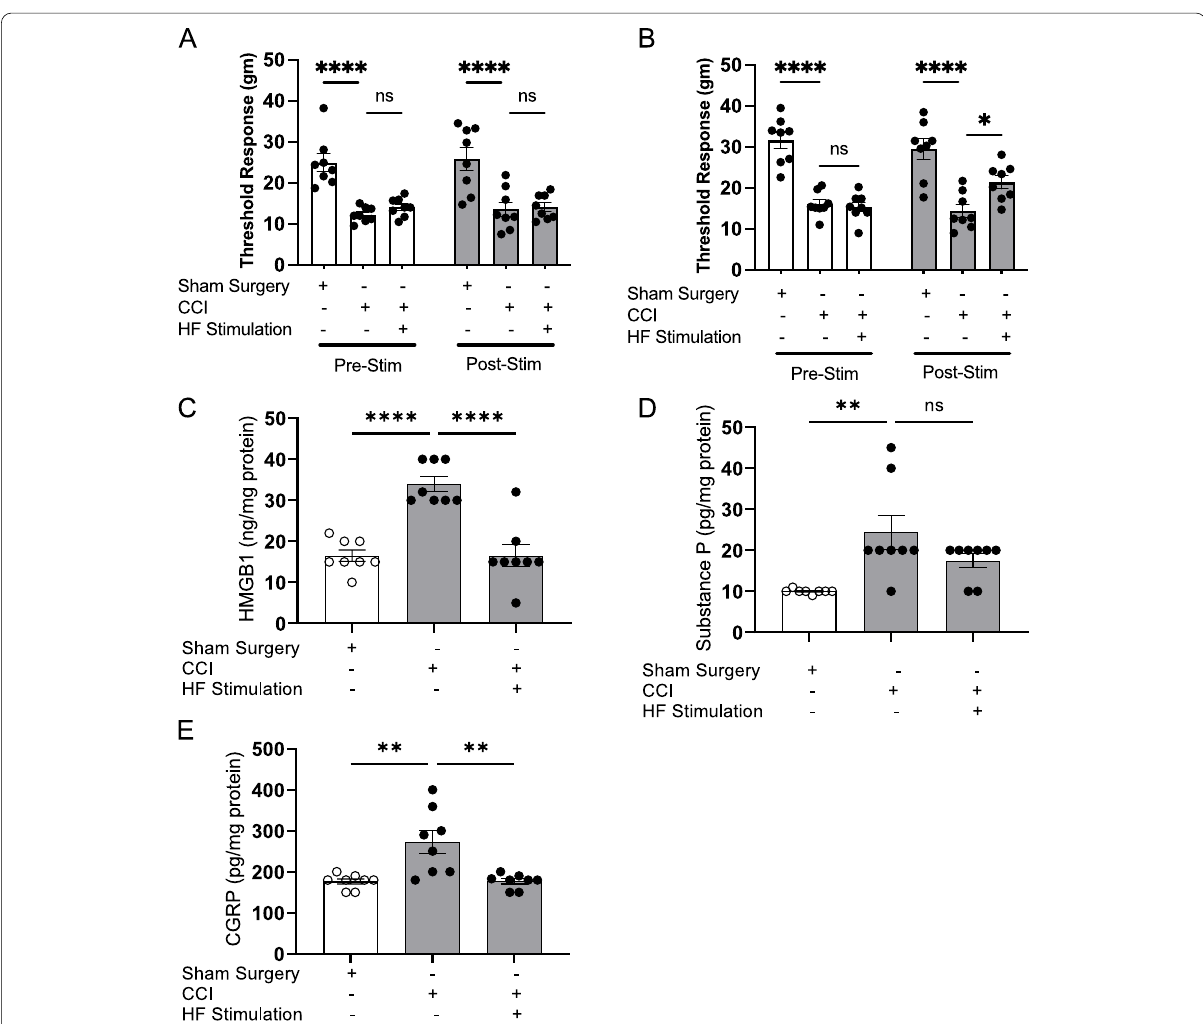
to CCI of the right sciatic nerve or sham surgery. Two weeks after sciatic nerve ligation surgery or sham surgery, animals were anesthetized, and transcutaneous high frequency electrical stimulation was applied for 5 min perpendicularly and parallel to the injury site, for a total of 10 min once a day A for 1 day or B for 3 consecutive days. Mechanical hypersensitivity (von Frey) was assessed at 24 h after the last stimulation. Data are represented as individual rat data points with mean SEM. Two‑way ANOVA was used followed by Tukey’s multiple comparisons test between ± groups. N 8‑12 per group. * P < 0.05, **** P < 0.0001. ns: not significant. C ‑ E CCI animals stimulated once a day for 3 consecutive days were = euthanized post‑mechanical hypersensitivity assessment and levels of C HMGB1, D substance P, and E CGRP were measured in the interstitial fluid of the inflamed paws. Data are represented as individual rat data points with mean SEM. One‑way ANOVA was used followed by Tukey’s multiple ± comparisons test between groups.